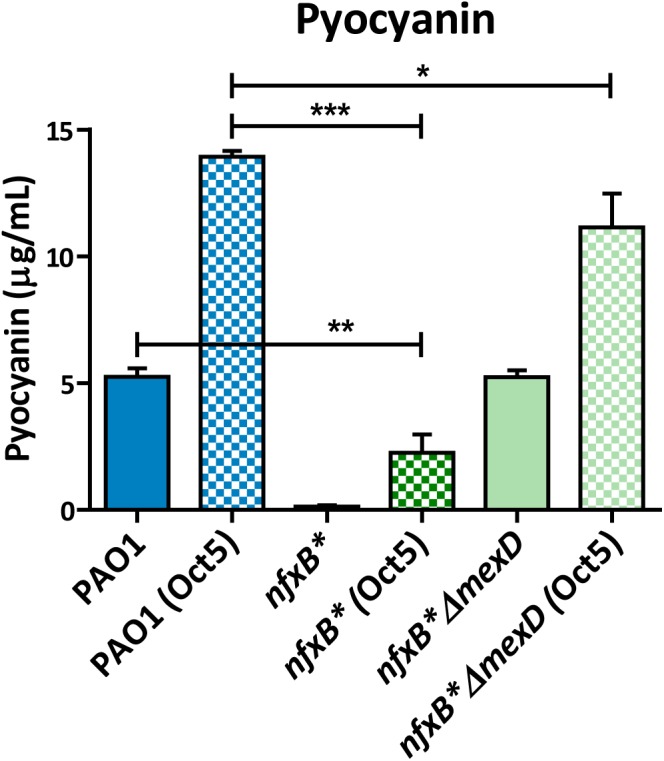
LB supplementation with octanoate increased the pyocyanin production in all analyzed strains, but nfxB∗ remained producing lower levels than those observed in PAO1 when grew in LB medium. For pyocyanin assay, the strains were grown in LB medium with or without octanoate (5 mM) along a time lapse of 20 h and the pyocyanin was extracted with chloroform-based protocol as is described in Methods. Statistical significances were evaluated by using a Student’s two-tailed test and considered significant if P < 0.05, with a confidence interval of 95% (∗P < 0.05; ∗∗P < 0.01; ∗∗∗P < 0.001). The results show that supplementation of LB with 5 mM octanoate, even allowing nfxB∗ strain increase the pyocyanin production, was insufficient to reach the levels produced by PAO1 in LB without octanoate. This indicate that a hypothetical low intracellular accumulation of octanoate is not the main cause for defective pyocyanin production observed in nfxB∗ strain.